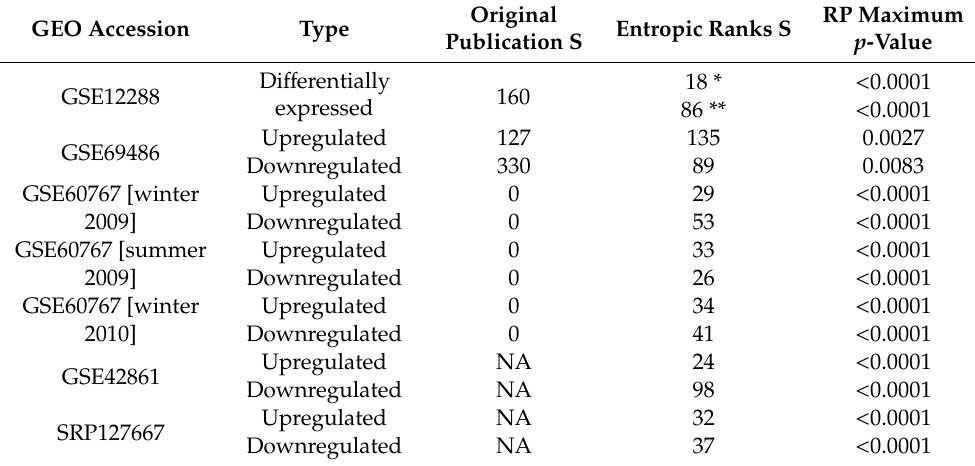
Table 1. Number of di ff erentially expressed features identified in the initial study compared with entropic rank results. The last column notes the maximum p -value calculated through rank products for these features. The number of features shows no correlation with sample size and the number identified in the initial research. GEO Accession Type